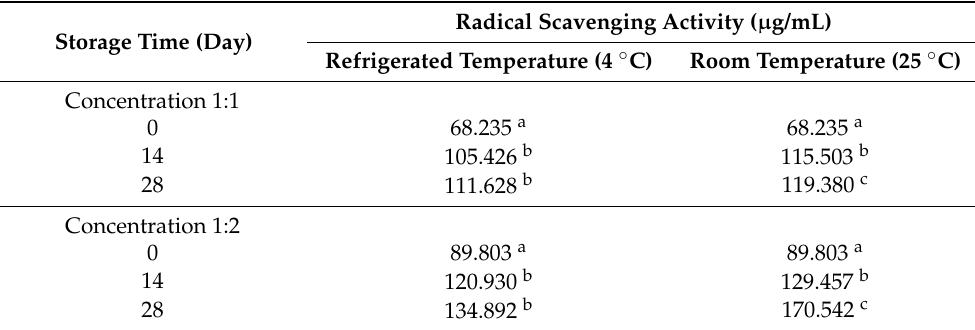
Table 4. Hydroxyl radical scavenging activity of Lactobacillus fermentum InaCC B1295 in CMFH- OPEFB at different temperatures for 28 days of storage.